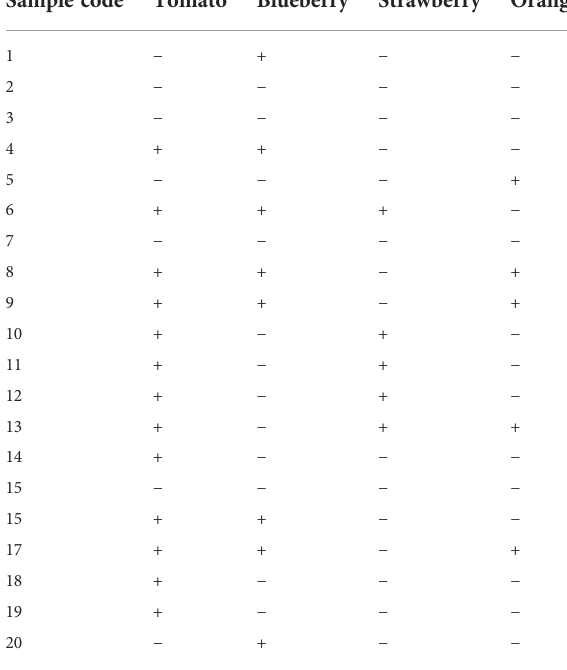
Symbol (-) represented the absence of effect of SWEs on the studied pathogens. Symbol (+) was associated with the positive effect of SWEs with the inhibition haloes on the studied